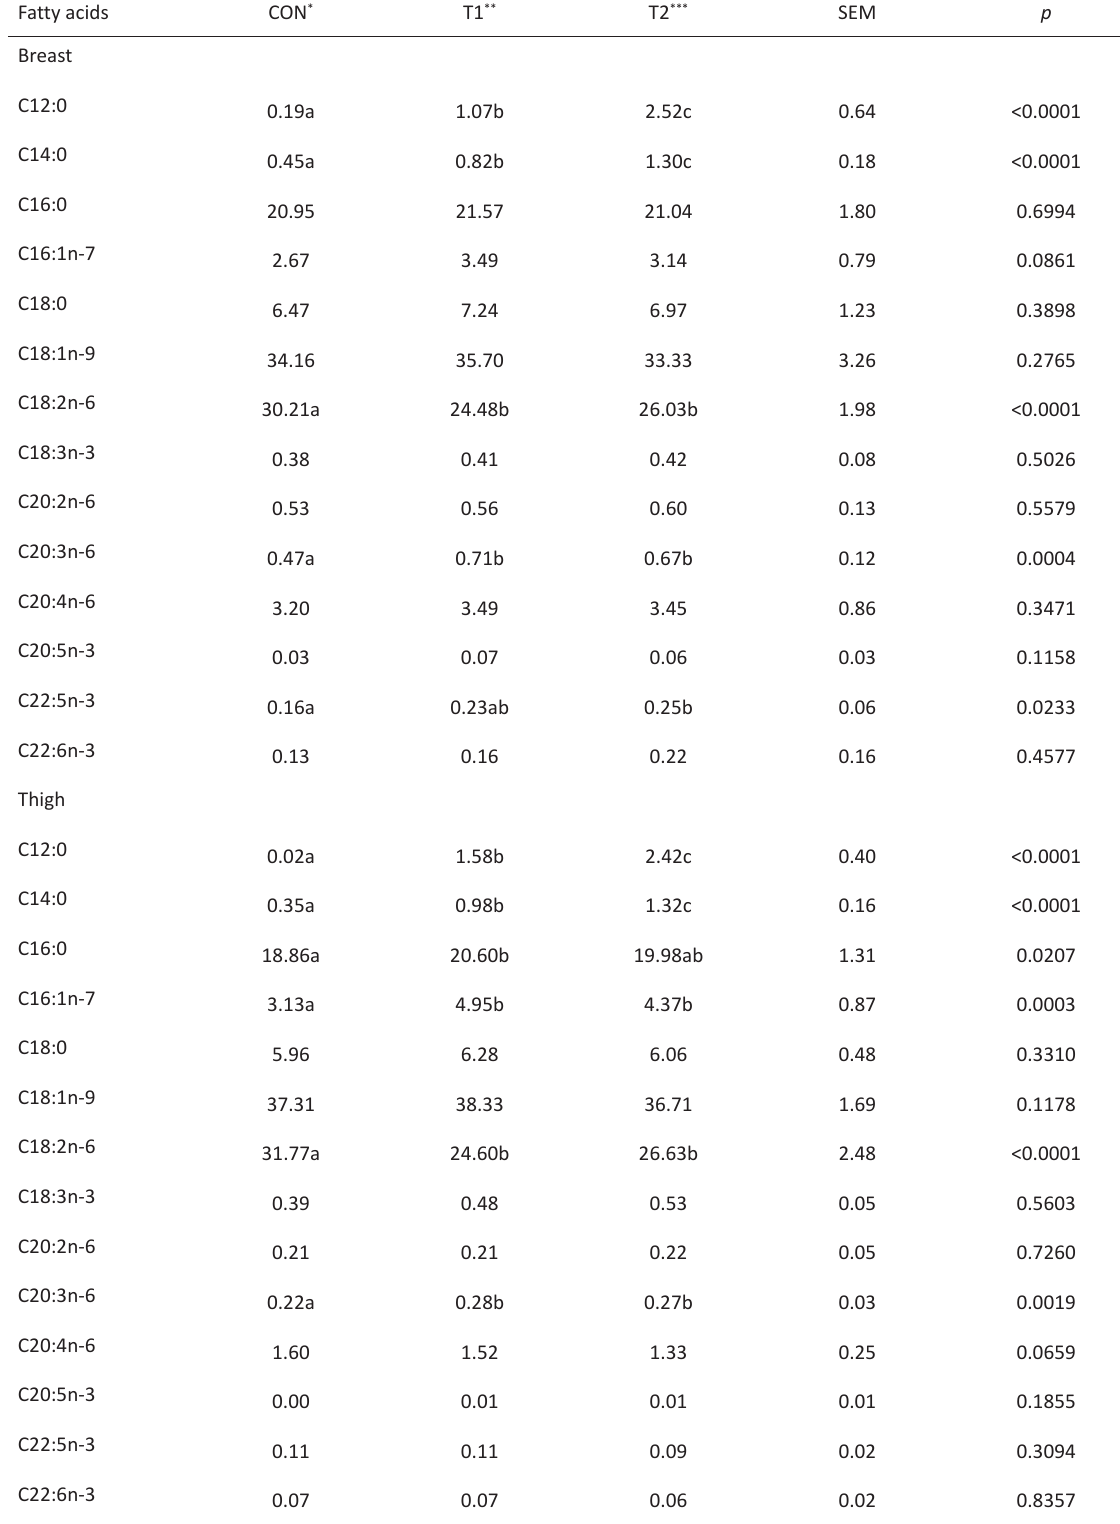
Table 6. Fatty acid (% FAME) composition of the breast and thigh meat Fatty acids CON * T1 ** T2